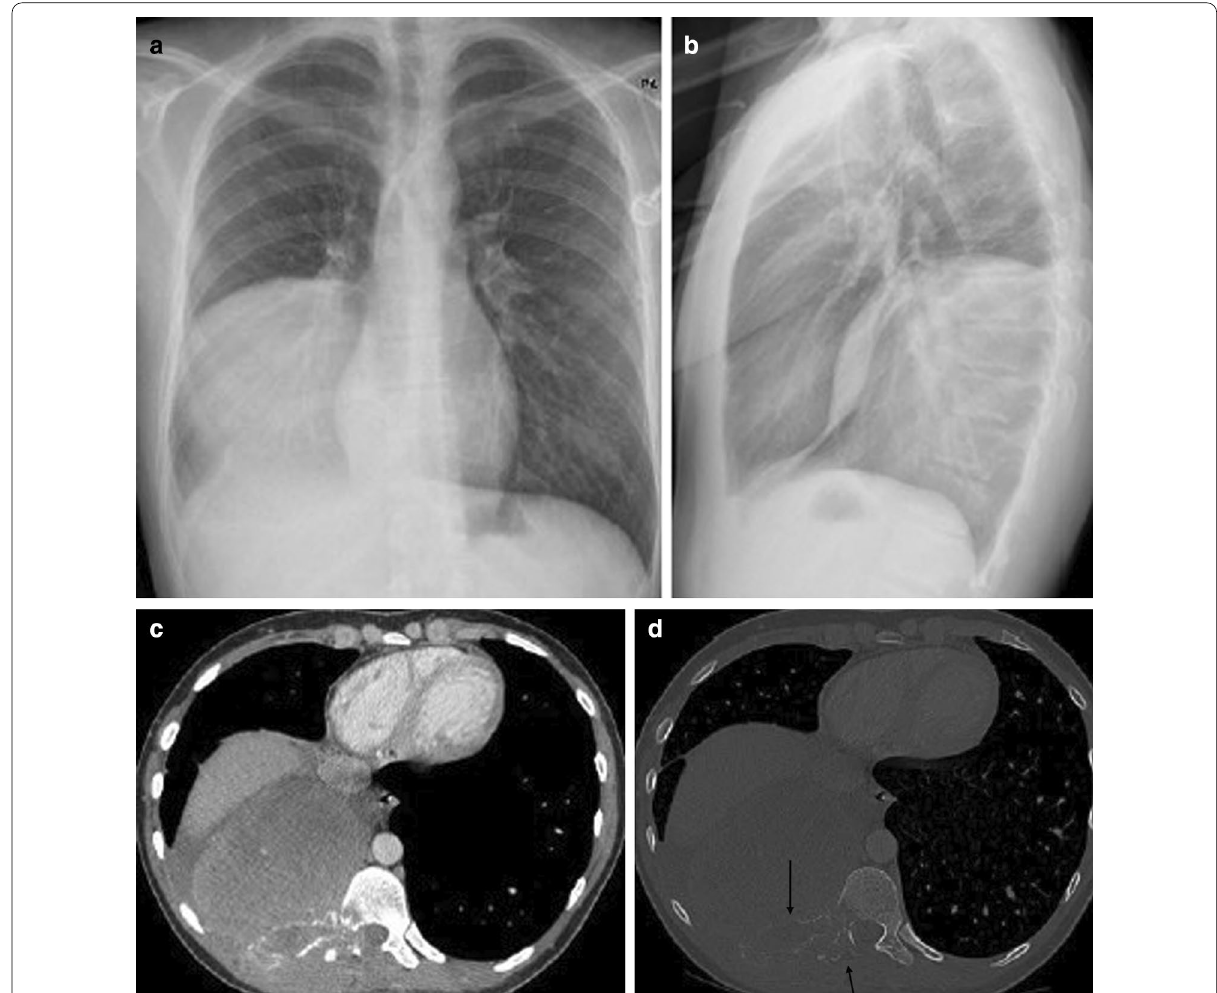
Fig. 13 Diagnosis: extraskeletal Ewing sarcoma. Technique: standard chest radiography and contrast-enhanced chest CT. Description: A 17-year-old man presented with localized right-sided chest pain. Postero-anterior and lateral chest radiographs ( a , b ) show a well-delineated mass located posterior in the right lung. Axial contrast-enhanced CT ( c ) in the mediastinal window setting shows a heterogeneous mass with intralesional necrosis and focal bony destruction of the corpus of the vertebra, pedicle, and the posterior side of the rib (arrows), best seen in the bone window ( d ). The young age of the patient, locoregional bone destruction, and extensive soft tissue component is suggestive of an extraskeletal Ewing